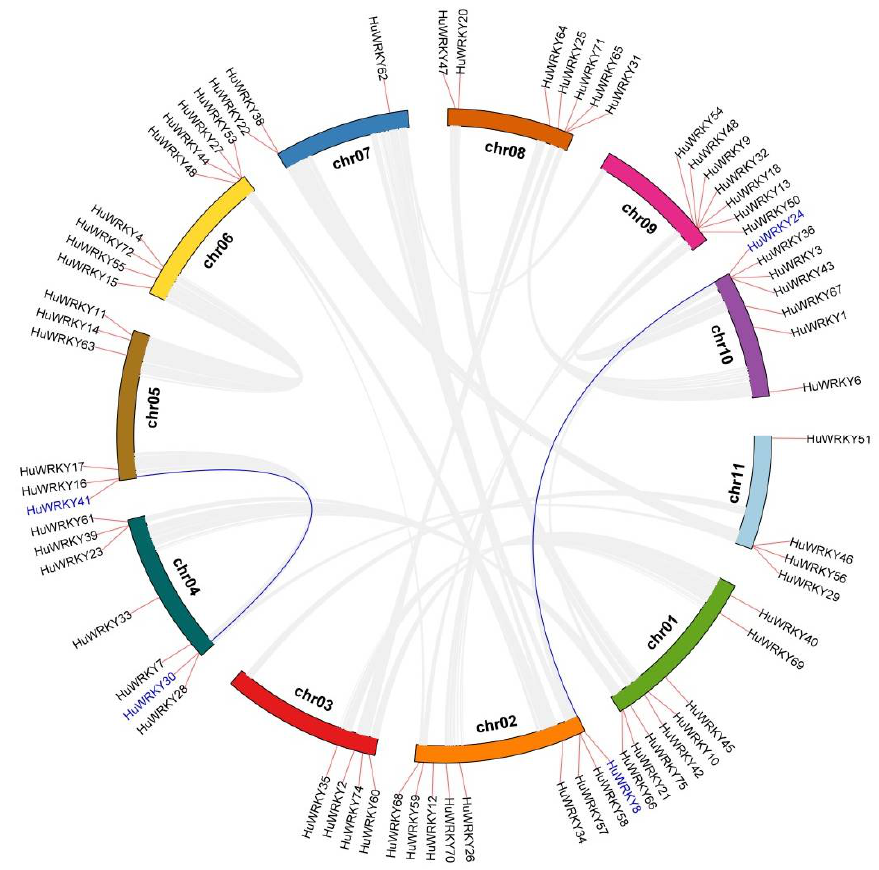
Figure 3. The synteny analyses of HuWRKY genes. Eleven chromosomes are drawn in different colors. The chromosome location of HuWRKY genes is shown by short red lines on the circle. Gray lines indicate all synteny blocks in the pitaya genome, and the blue lines indicate the duplication of HuWRKY gene pairs.